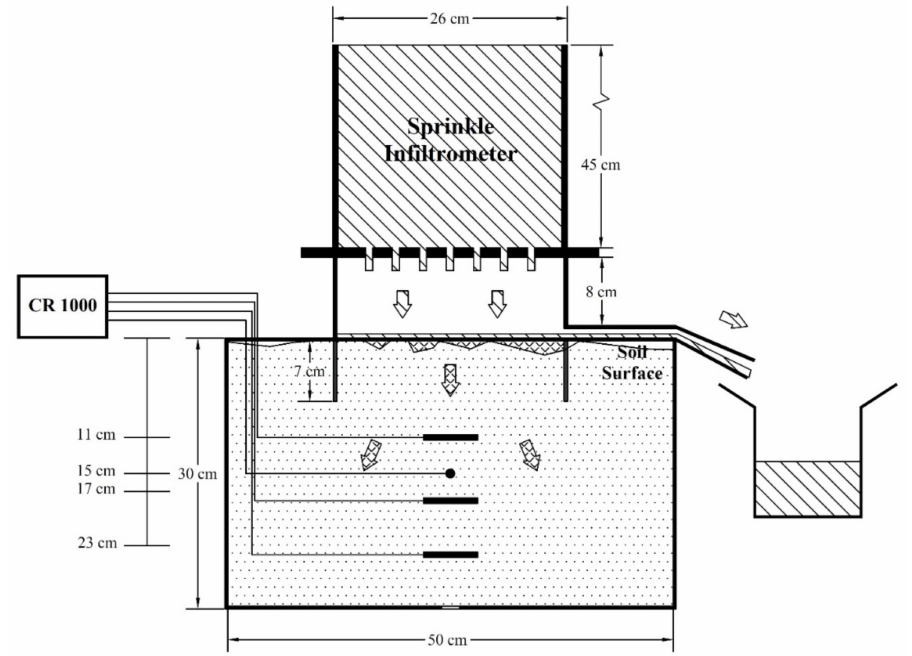
Figure 5. Schematic of the experimental setup.